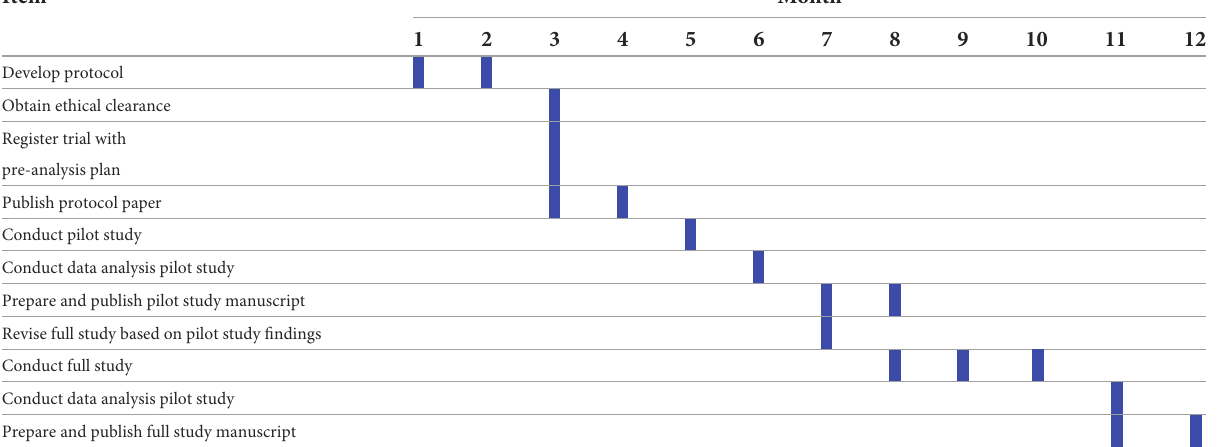
TABLE 2 Overview of study